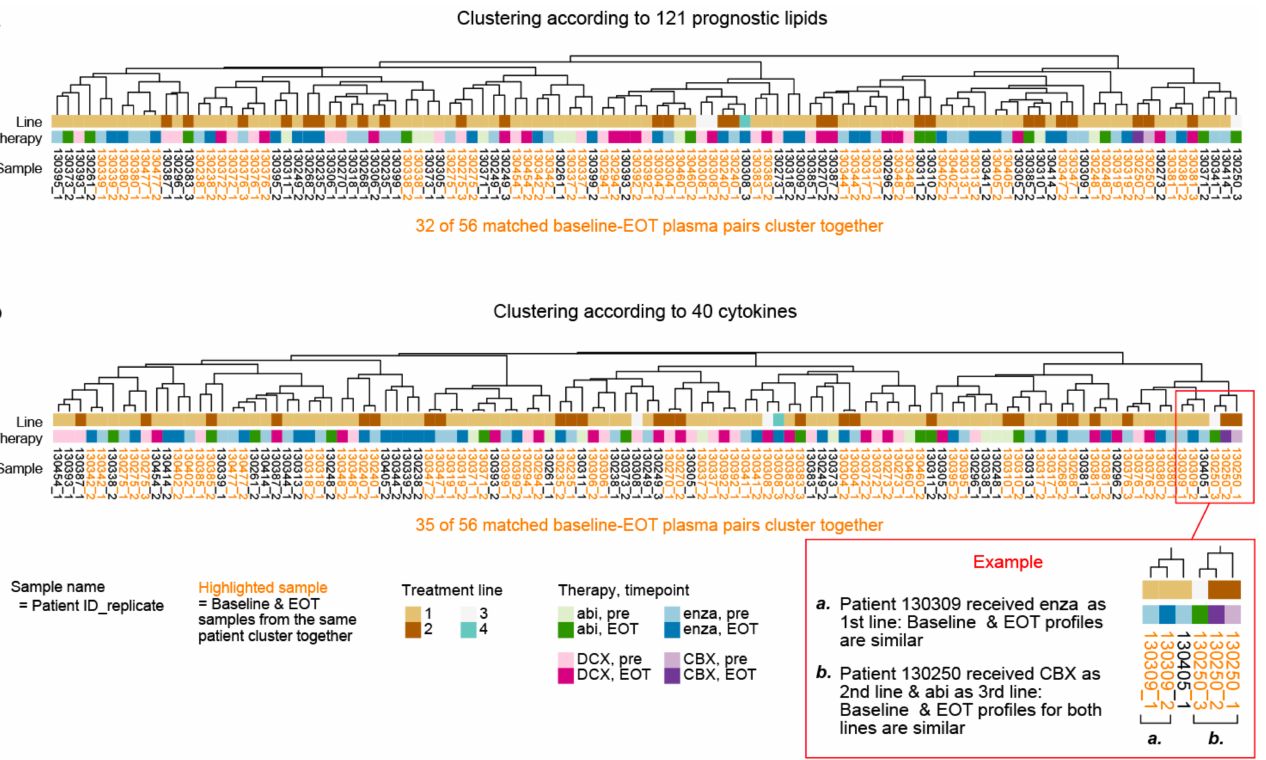
Figure 5. Hierachical clustering of 56 pairs of matched baseline and EOT plasma samples for Cohort 2b. Samples are clustered according to the profiles of 121 prognostic lipids ( a ) or 40 cytokines ( b ). Matched baseline and EOT samples that paired together (cluster next to each other) are highlighted in orange. Heatmaps of the lipid or cytokine levels are displayed in Figure